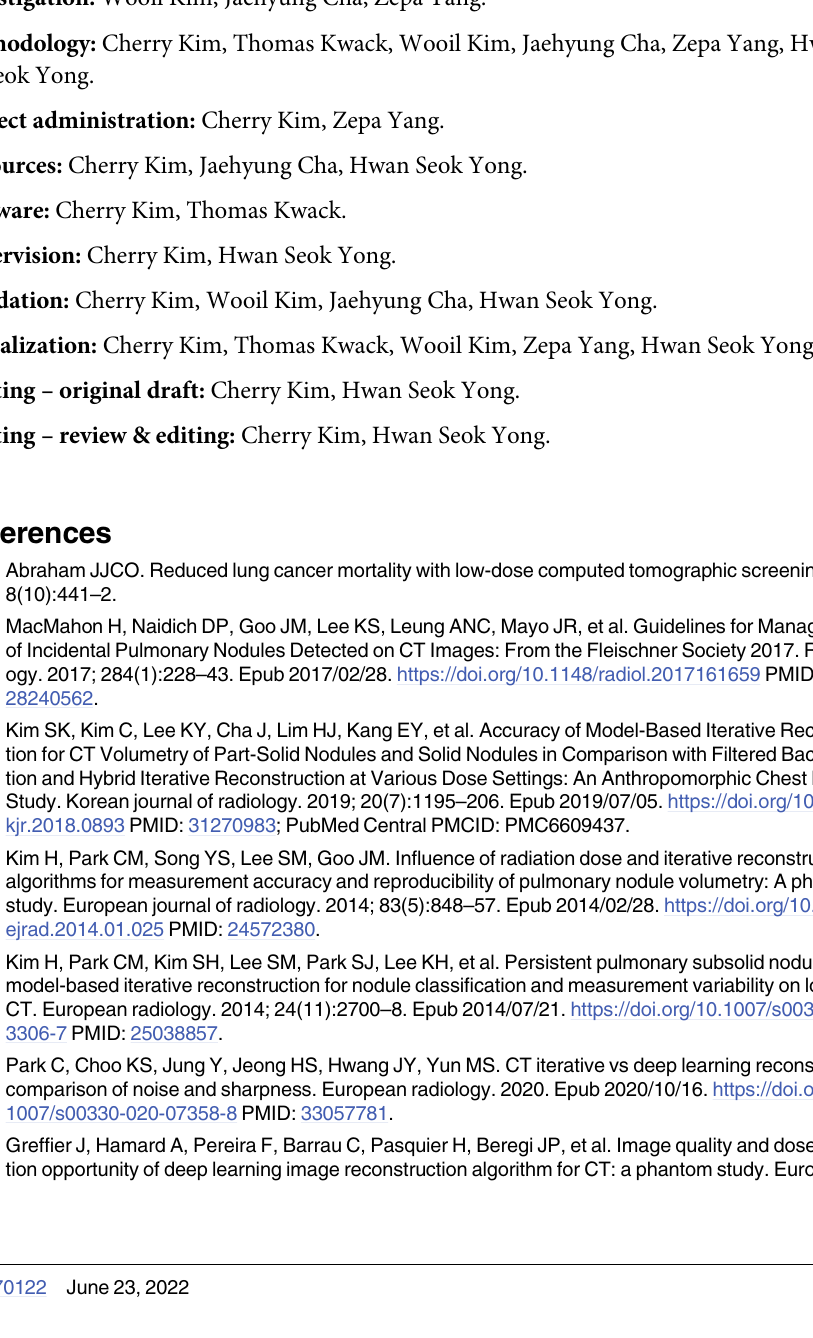
S2 Table. The NPS peak and average spatial frequency data at each dose